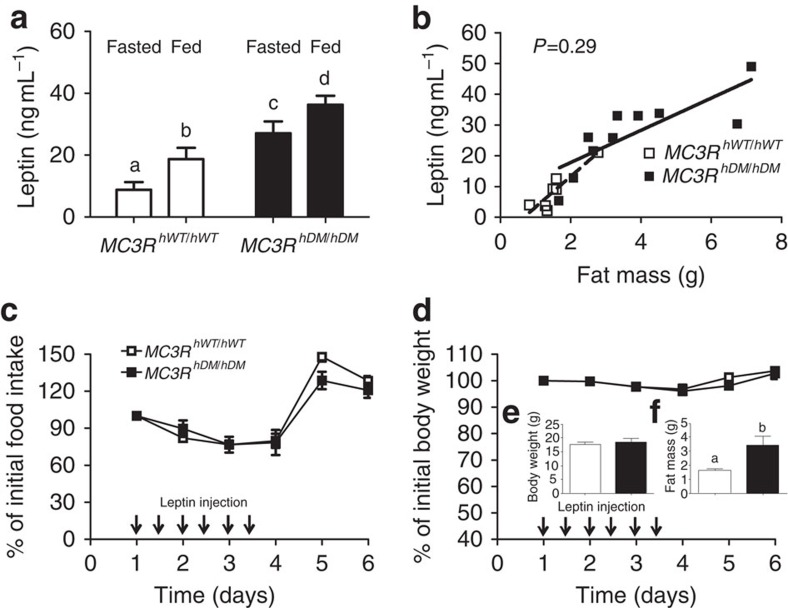
Maintained leptin sensitivity in MC3RhDM/hDM mice.Blood was collected from tail veins of female MC3RhWT/hWT (open symbols) and MC3RhDM/hDM (closed symbols) mice. (a) Serum leptin concentrations were measured in fed (n=10 per group) and fasted (n=7 per group) conditions. (b) Serum leptin concentrations were significantly correlated with body fat mass in both MC3RhWT/hWT (dotted line; P<0.0041) and MC3RhDM/hDM (solid line, P<0.0043) mice, but these slopes were not significantly different (P=0.29) and leptin values were not different after results were adjusted for fat mass. (c,d) 2-month-old chow-fed mice (n=5 per group) were injected twice daily with mouse leptin (1 μg g−1 body weight, arrows) for 3 days. (c) Food intake and (d) body weight were measured daily. Inset bar graphs (e,f) show body weight and fat mass of the mice given leptin. Data are represented as mean±s.e.m. A different letter represents significant differences at P<0.05 compared with the other groups. Groups were compared by one-way (a) and two-way (c,d) analysis of variance followed by Bonferroni post-tests, Student's t-tests (two-tailed) (e–f), and analysis of covariance (b).